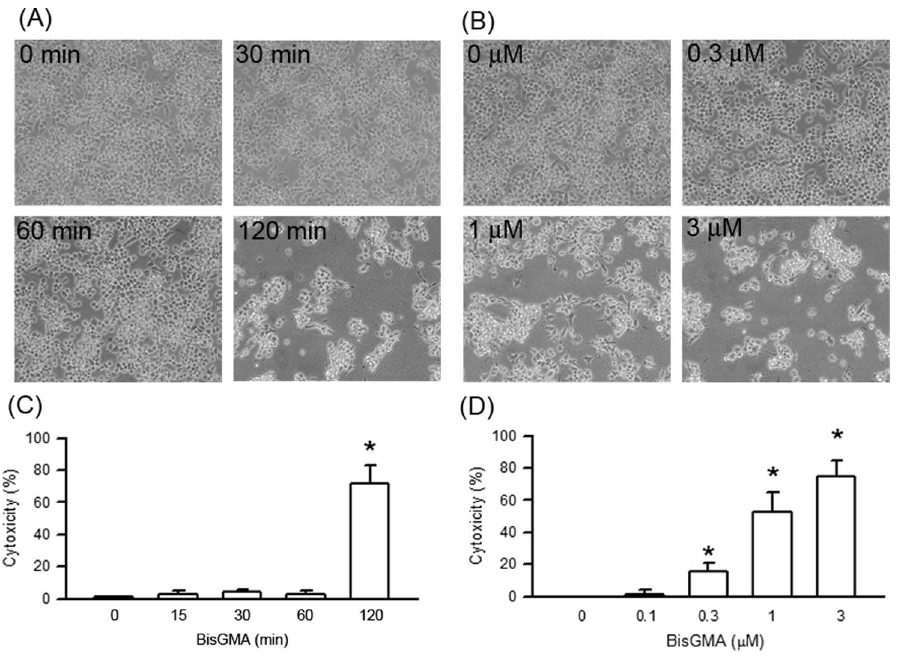
Figure 1. Cytotoxicity and effects of BisGMA on the morphology of RAW264.7 macrophages. (A) Cells were exposed to 3 m M BisGMA for the indicated treatment periods. (B) Cells were exposed to the indicated concentrations of BisGMA for 2 h. The morphology exchange were observed with an inverted microscope (Original magnification 6 200). (C) Cells were exposed to 3 m M BisGMA for the indicated treatment periods measured by LDH assay. (D) Cells were exposed to the indicated concentrations of BisGMA for 2 h. Values are expressed as mean 6 SD (n=5). *represents significant difference from control values with p , 0.05.